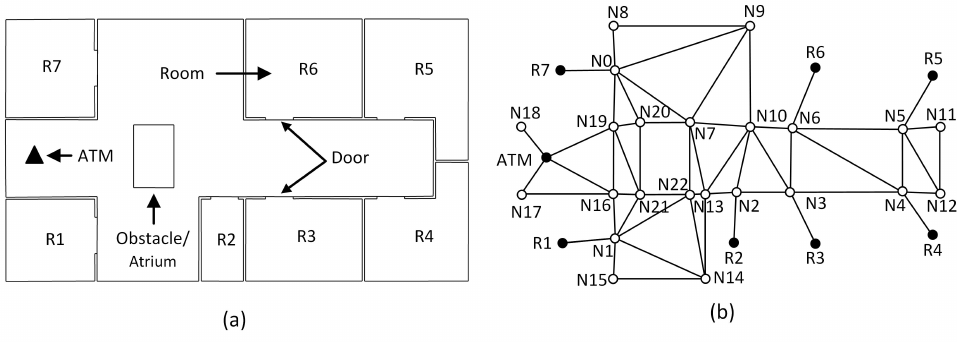
Figure 1. An indoor map and its navigation network. ( a ) Indoor map used for illustration. ( b ) Navi- gation network corresponding to the indoor